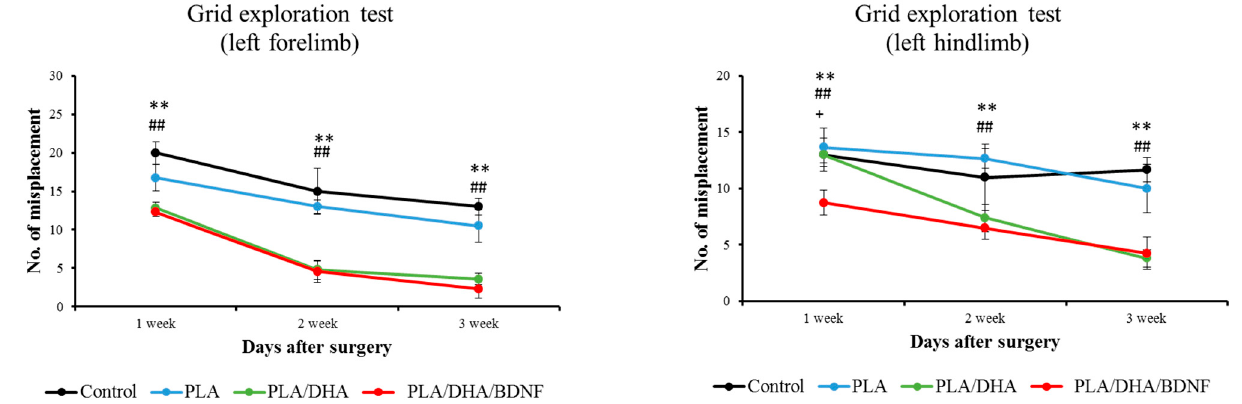
Figure 9. The evaluation of the neurological function recovery by the grid exploration test. ** p < 0.01 PLA/DHA/BDNF vs. control; ## p < 0.01 PLA/DHA/BDNF vs. PLA; + p < 0.05 PLA/DHA/BDNF vs. PLA/DHA.